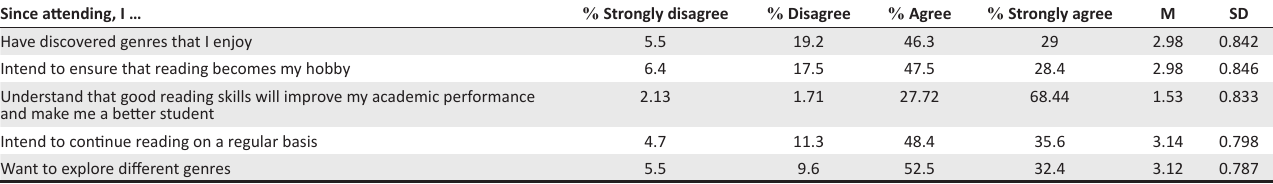
FIGURE 3: Read both books at Vaal University of Technology (VUT). TABLE 5: Future intentions ( N =